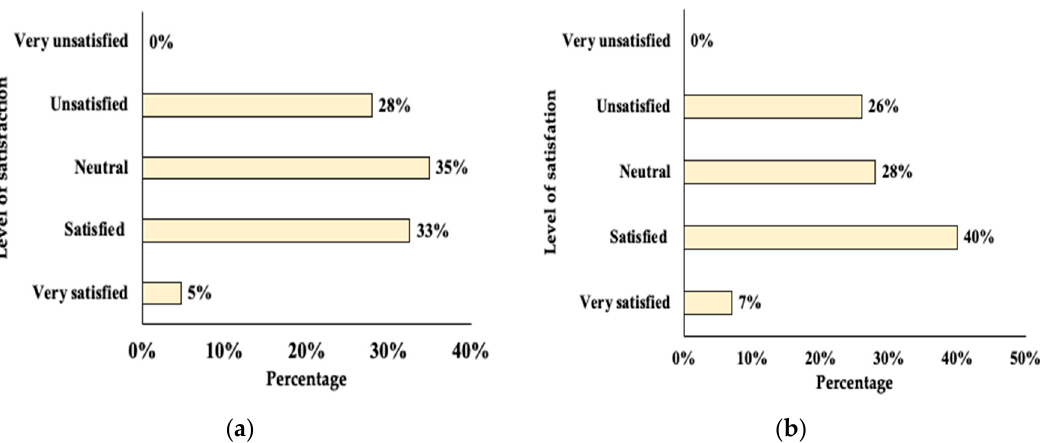
Figure 8. Perception of satisfaction ( a ) with products available in the market and ( b ) with suppliers of the market.